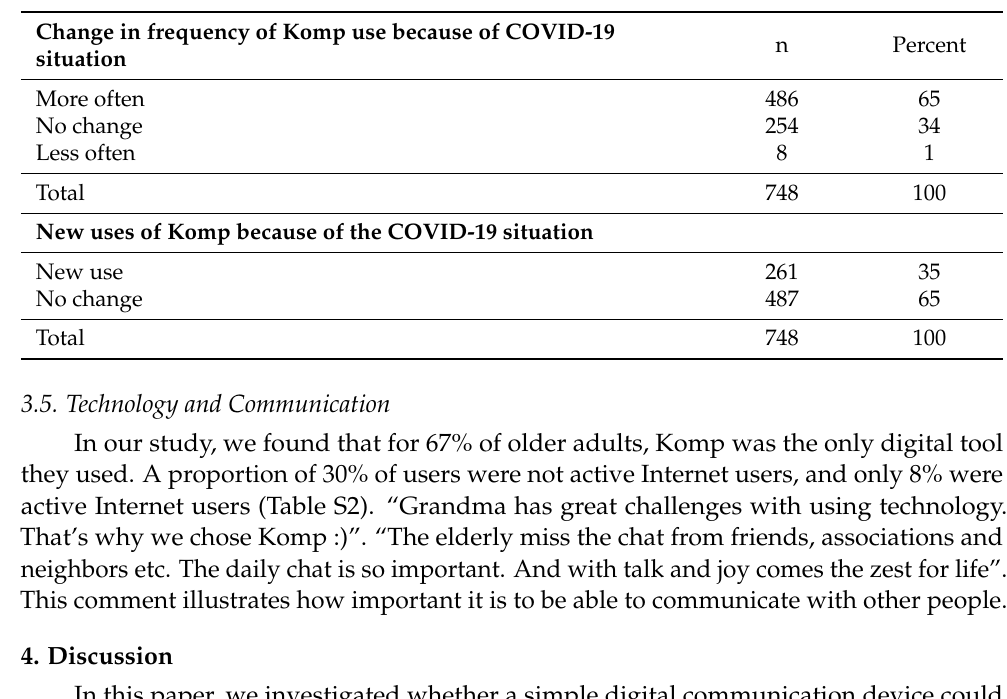
Table 3. Impact of COVID-19 on the use of Komp; N =